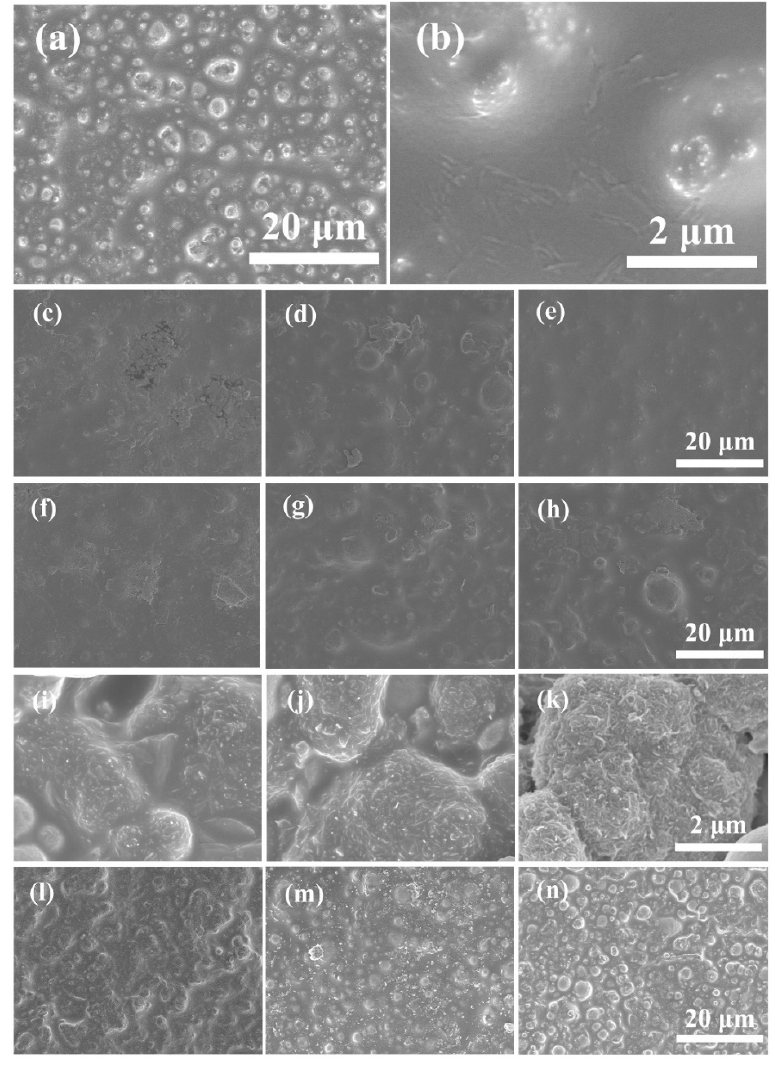
Figure 3. SEM images of the unmodified and modified sample surfaces: ( a , b ) 80Zn; ( c ) 1CB-80Zn; ( d ) 2CB-67Zn; ( e ) 4CB-67Zn; ( f ) 1CG-80Zn; ( g ) 2CG-67Zn; ( h ) 4CG-67Zn; ( i ) 1MWCNT-80Zn; ( j ) 2MWCNT-67Zn; ( k ) 4MWCNT-67Zn; ( l ) 1PANI-80Zn; ( m ) 2PANI-67Zn; ( n ) 4PANI-67Zn.